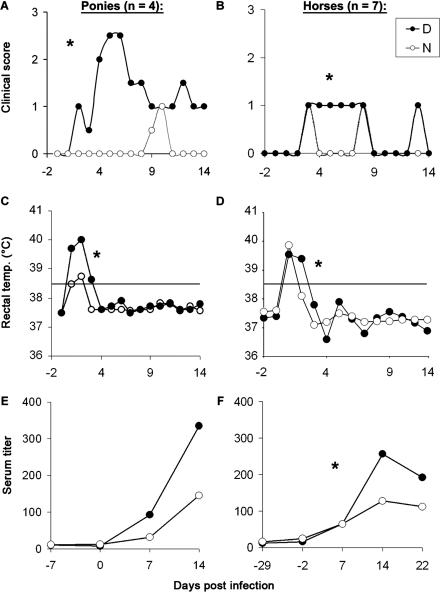
Clinical Data from the Equine Experimental Infection StudiesStudies were conducted in a smaller pilot study (ponies) and subsequently a larger study (horses) with the revertant pol genotype virus (D752, •) and mutant virus (N752, ○). Data were collected before and after treatments. *p < 0.05.(A and B) Median cumulative clinical scores, which indicate overall symptom severity.(C and D) Median rectal temperatures (°C), with a line drawn at the cutoff temperature for fever (38.5 °C).(E and F) Median serum virus neutralizing antibody titers. Data from the first experiment on ponies (four animals/group) are shown in the left graphs (A, C, and E), those from the second experiment on horses (seven animals/group) in the right graphs (B, D, F).